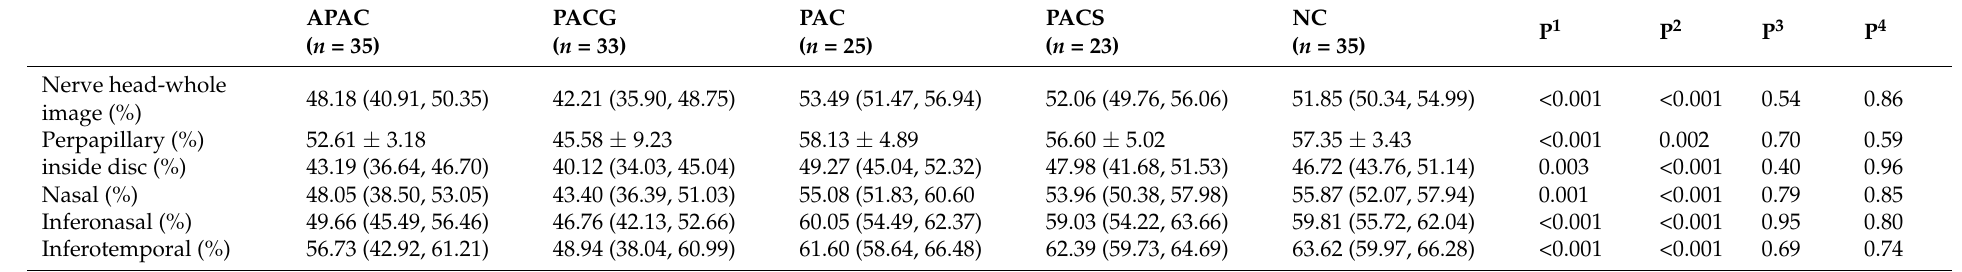
APAC groups. P 2 represents the p -value associated with the comparisons between control and PACG groups. P 3 represents the p -value associated with the comparisons between control and PAC groups. P 4 represents the p -value associated with the comparisons between control and PACS groups. Table 2. Vessel density in peripapillary sectors of the nerve head layer and radial peripapillary capillary